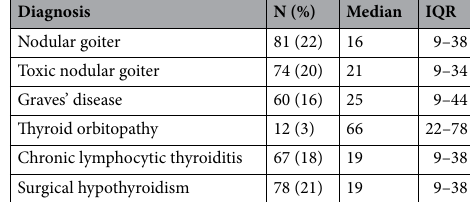
Table 2. Response of patients with benign thyroid diseases to the “eye symptoms” section of the ThyPROpl questionnaire. IQR interquartile range, N the number of valid answers.